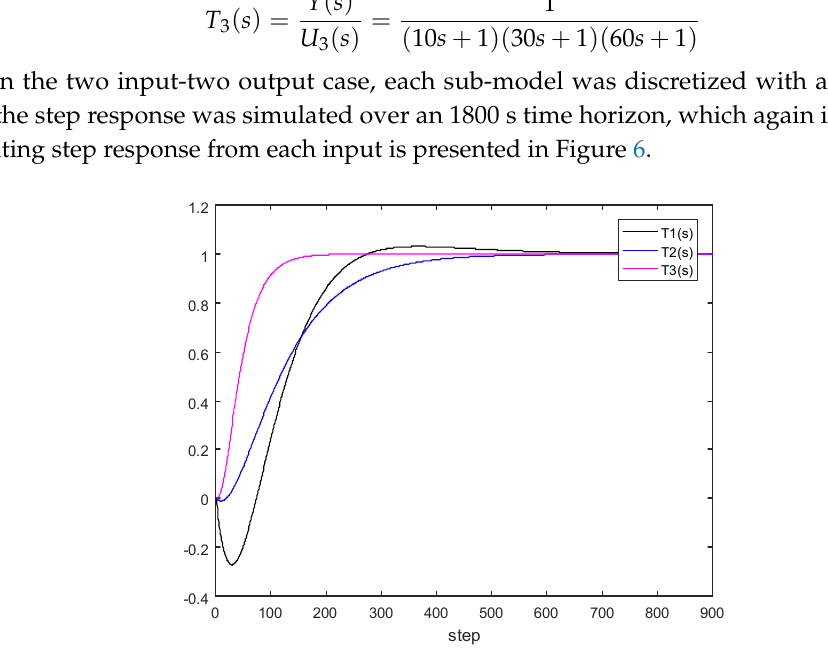
Figure 6. Step response for T 1 , T 2 , and T 3 transfer functions simulated for 900 time-steps.